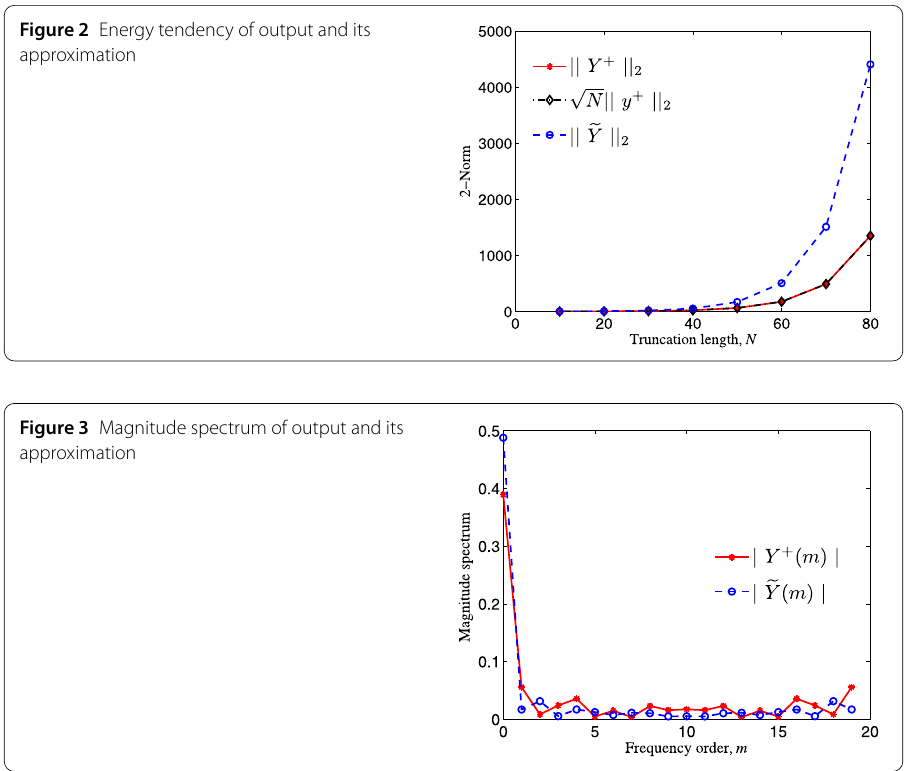
Figure 3 Magnitude spectrum of output and its